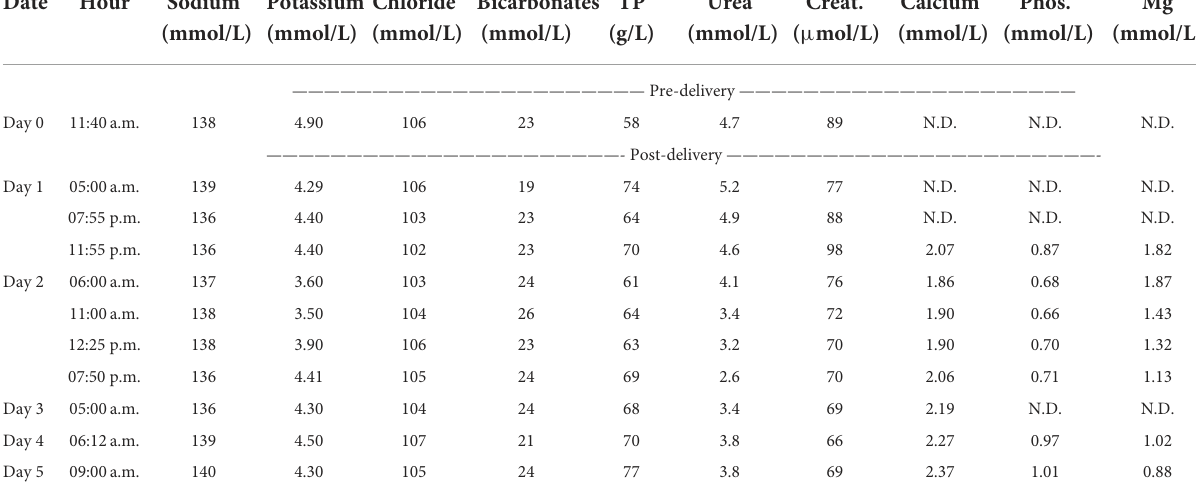
TABLE 1 Changes in biochemical parameters in blood during Takotsubo